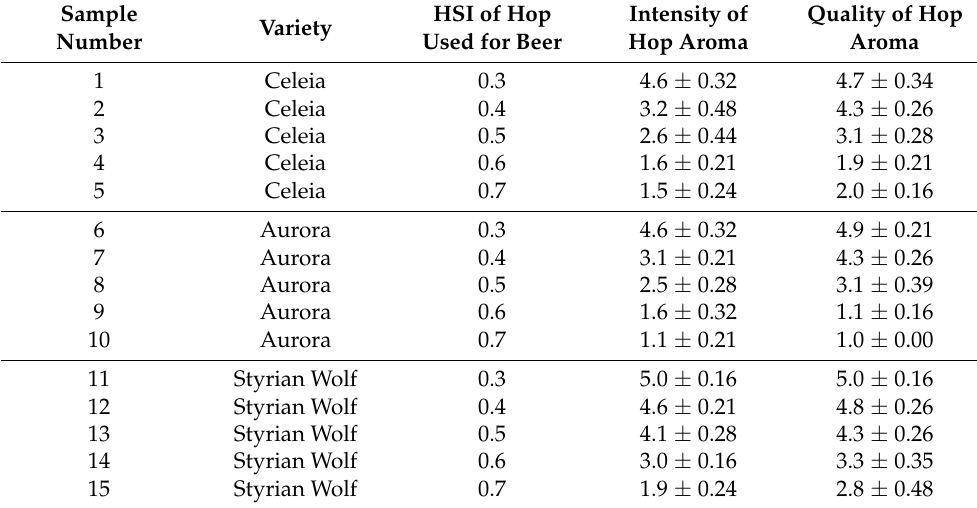
Table 4. Results of sensorial analysis for intensity and quality of beer aroma, presented as mean value ± standard